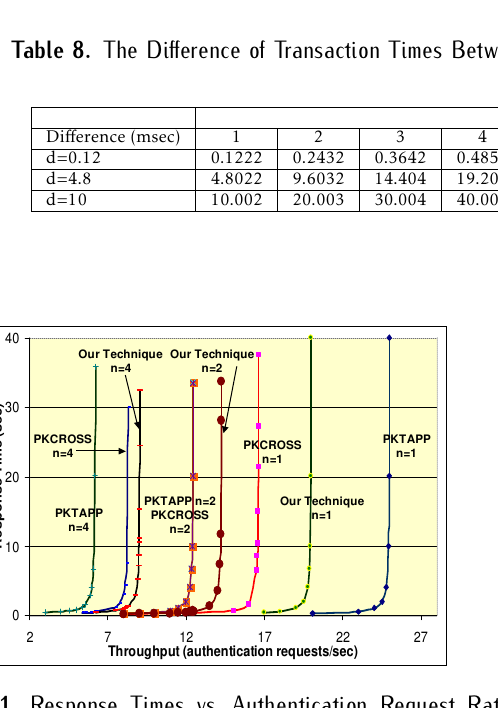
Figure 11. Response Times vs. Authentication Request Rates when m = 1